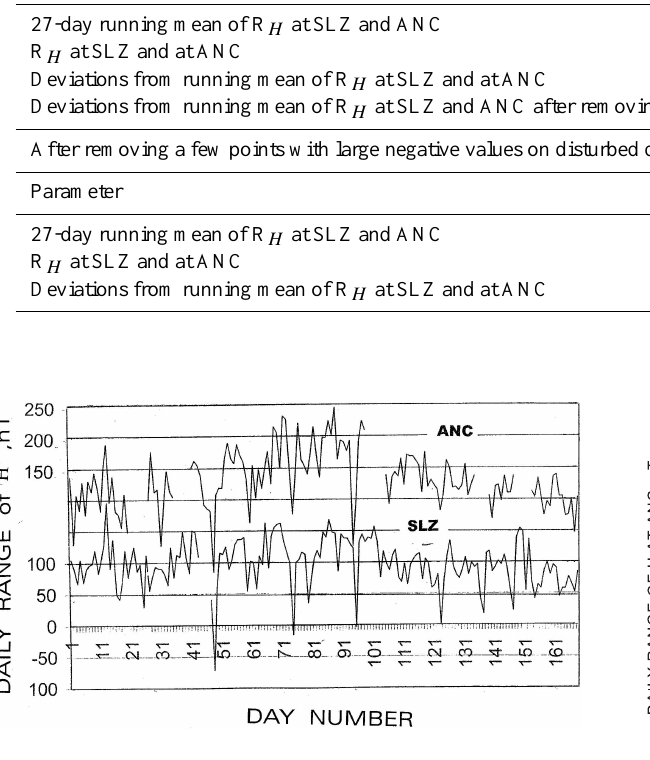
Table 2. Regression and correlation coefficients of fluctuations in R H at SLZ and ANC. Parameter